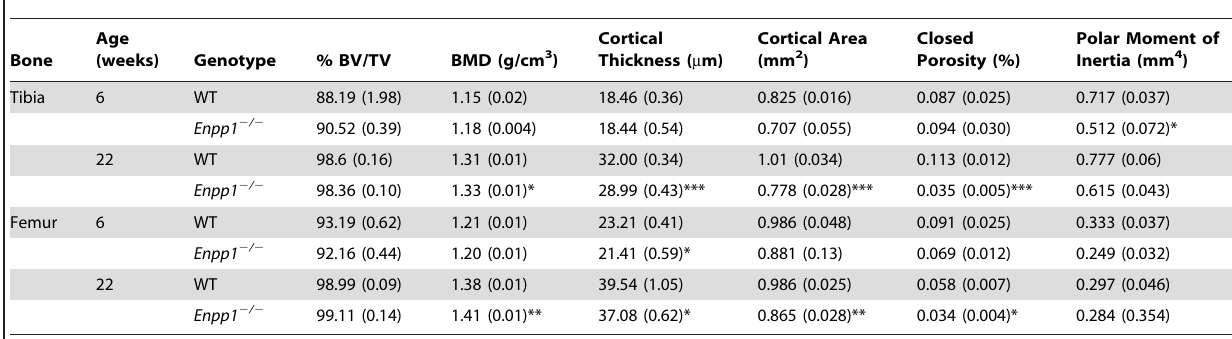
Table 3. MicroCT analysis of cortical bone in male wild-type and Enpp1 2 / 2 mice.